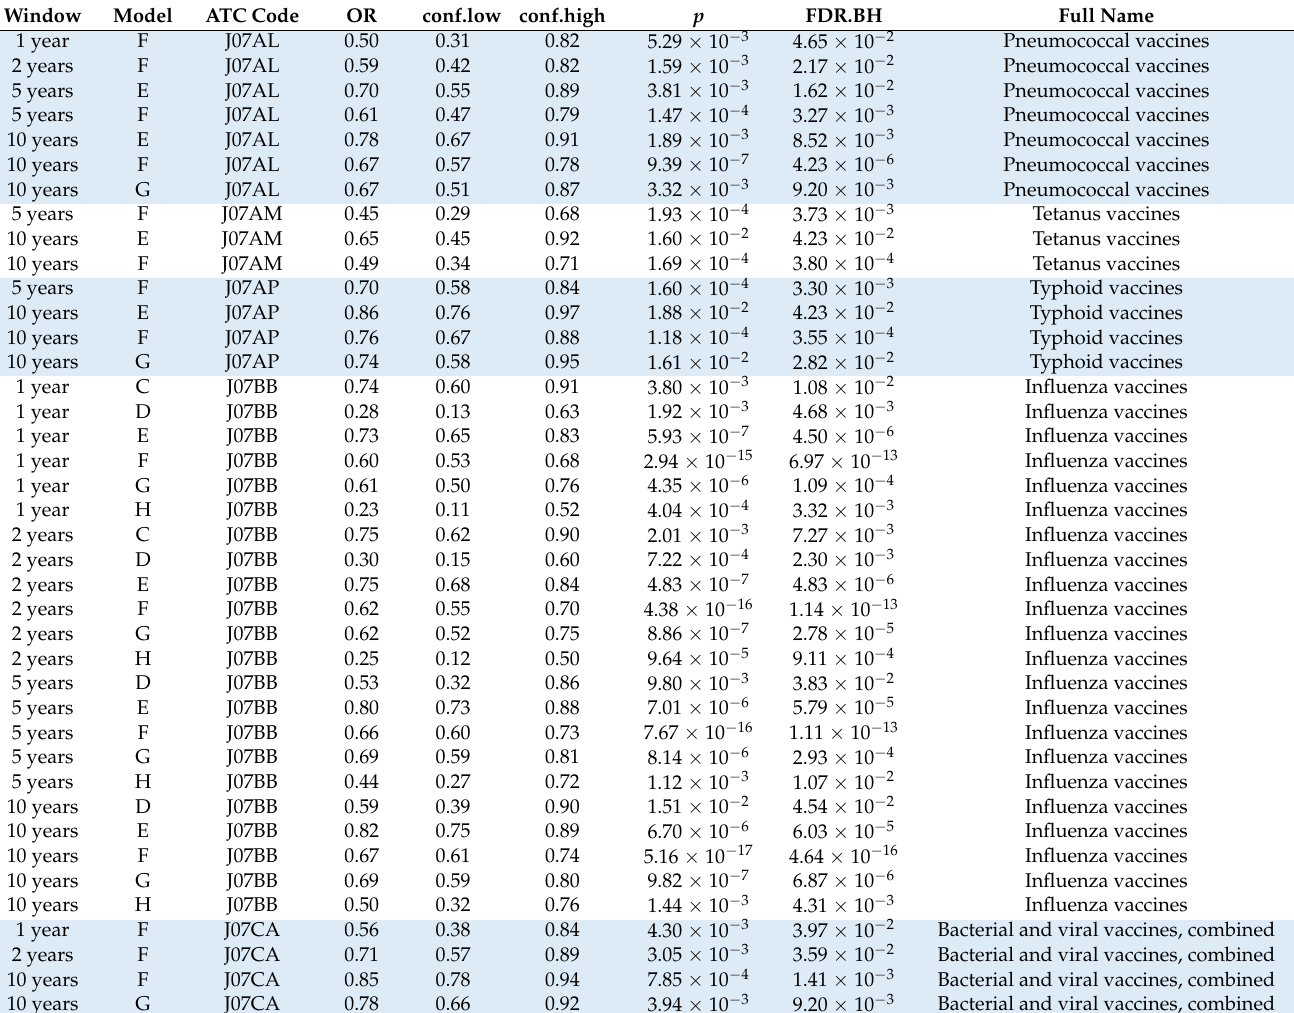
Table 5. Vaccines with significant protective associations (limited to FDR < 0.05) within time windows of 1, 2, 5, and 10 years. Window